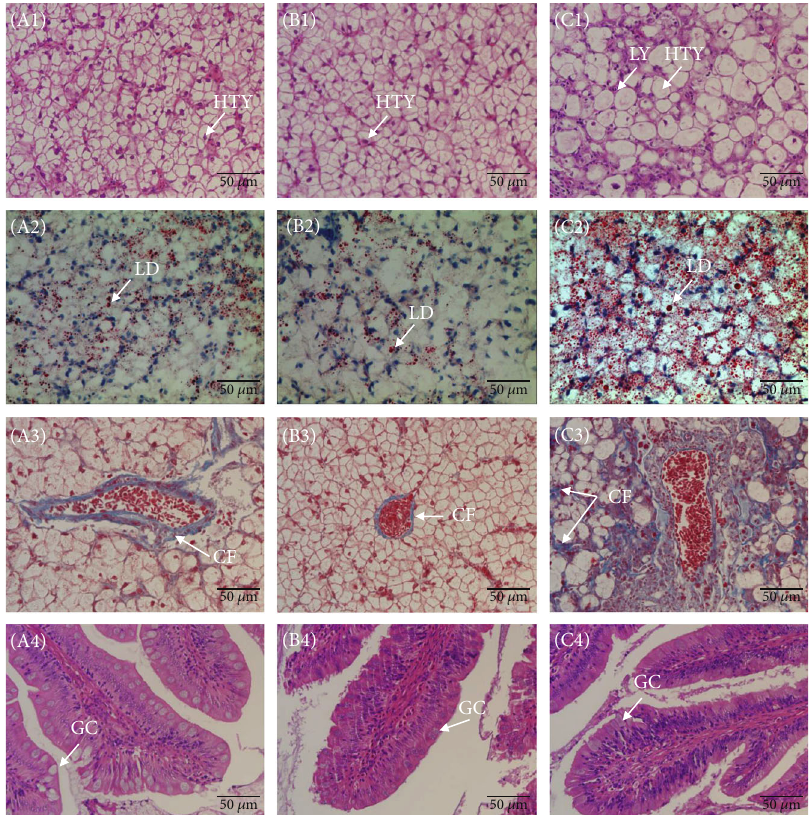
Figure 5: Photo of liver (rows 1 to 3) and intestinal sections (row 4) of largemouth bass, Micropterus salmoides , fed the CON (A1-A4), SB2 (B1-B4), and SB20 (C1-C4) diets. HTY: hepatocytes; LY: lymphokines; LD: lipid droplets (red); CF: collagen fi bre (blue); GC: goblet